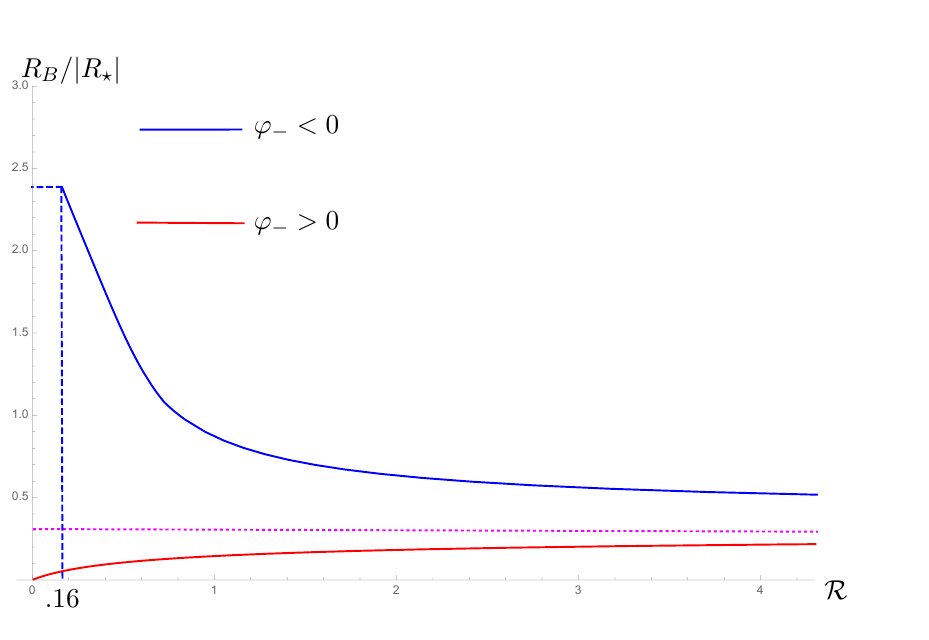
Figure 9 . R B = j R ? j as a function of R for bulk potential (3.1), brane quantities (3.2) and parameter values (3.3). j R ? j is de(cid:12)ned as the ‘expected’ brane curvature related to the brane cosmological constant W B ( ’ ? ) in the absence of a 5d bulk. For R ! 1 both the red and blue branch asymptote to the value for R B = j R ? j indicated by the dotted magenta